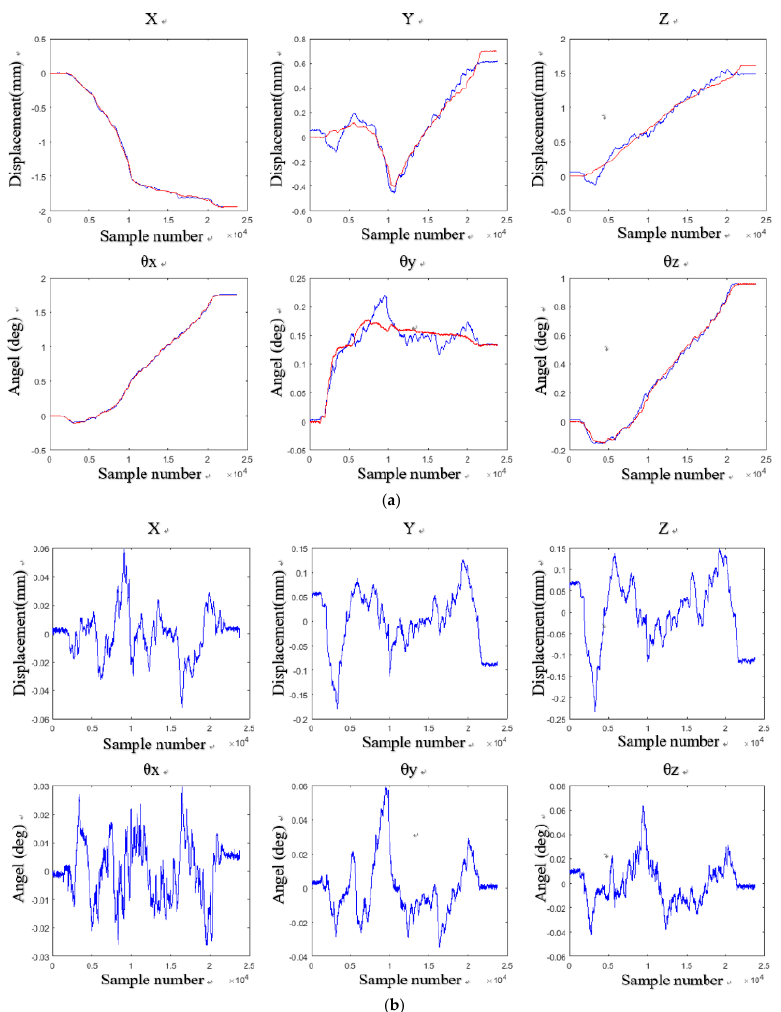
Figure 13. Six DOF measurement results and errors of the wafer Stage at the third test: ( a ) six DOF measurement results; ( b ) six DOF measurement errors. According to the measurement results, the six DOF measurement peak errors under different displacements are shown in Table 4. There was a peak error of 0.06 mm in the X direction, a peak error of 0.15 mm in the Y direction, and a peak error of 0.23 mm in the Z direction. The peak error of θ x , θ y , and θ z are 0.04°, 0.06°, and 0.07°. By analyzing the error of each degree of freedom, it can be noticed that the Z -direction, θ y and θ z measurement errors increase as the wafer displacement changes, while other degrees of freedom hardly change.